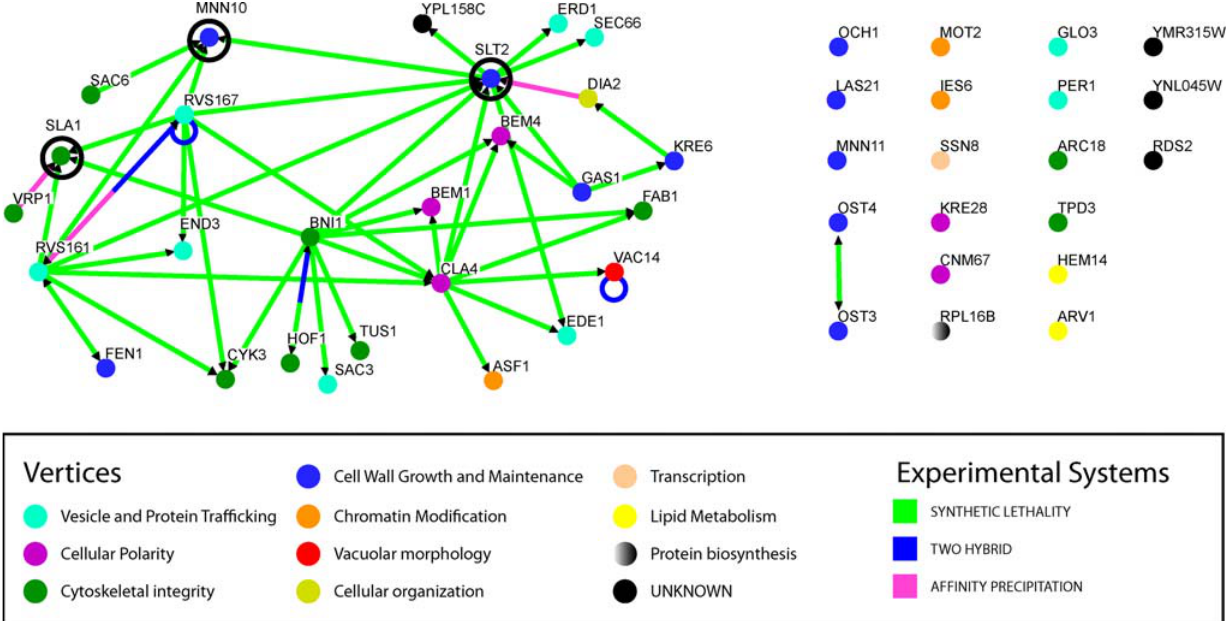
Figure 4. The Cell Wall Remodeling Network Required for b -Glucan Masking A map of physical and genetic interactions among b -glucan masking genes was made using the Osprey v1.2.0 visualization program (available at: http://biodata.mshri.on.ca/osprey/servlet/Index). All genes of hypereliciting mutants identified in the screen are represented. Lines connecting genes are colored to represent the nature of known interaction(s) between a pair of genes (i.e., synthetic lethality, two-hybrid, or coimmunoprecipitation). Vertices are colored to represent the cellular processes directed by the gene product, as annotated by the Yeast Proteome Database (available at http:// www.proteome.com). Vertices of genes required for caspofungin resistance [15,16] are circled in black. DOI: